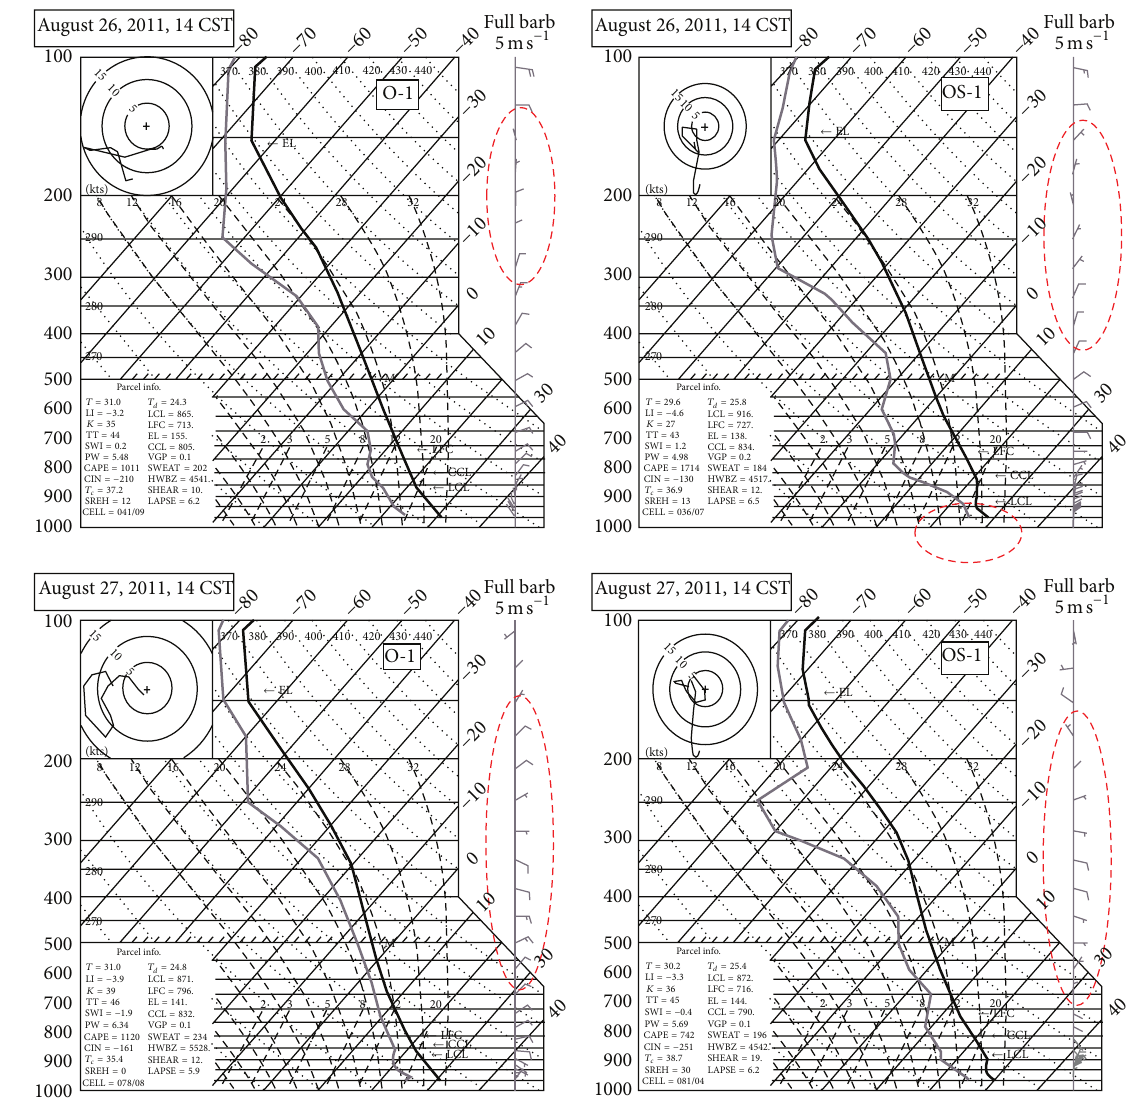
Figure 8: Modeled skew-temperature diagram for Zuoying (O-1) and Magong (OS-1) air quality monitoring stations for the invasion of typhoon Nanmadol (black line: temperature ( ∘ C); gray line: dew-point temperature ( ∘ C); wind vector full barb = 5